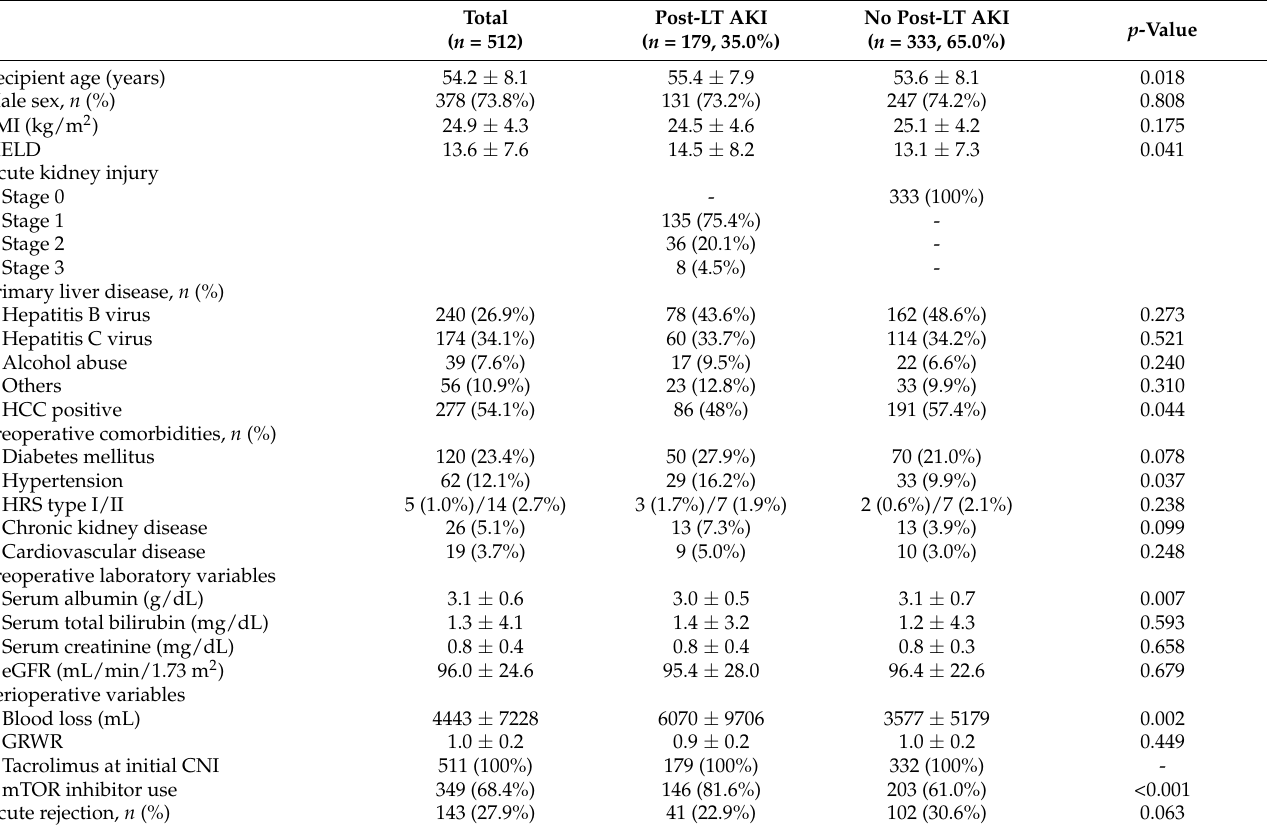
Table 1. Characteristics of the Patients Undergoing Living Donor Liver Transplantation. Total Post-LT AKI No Post-LT AKI ( n = 512) ( n = 179, 35.0%) ( n = 333,